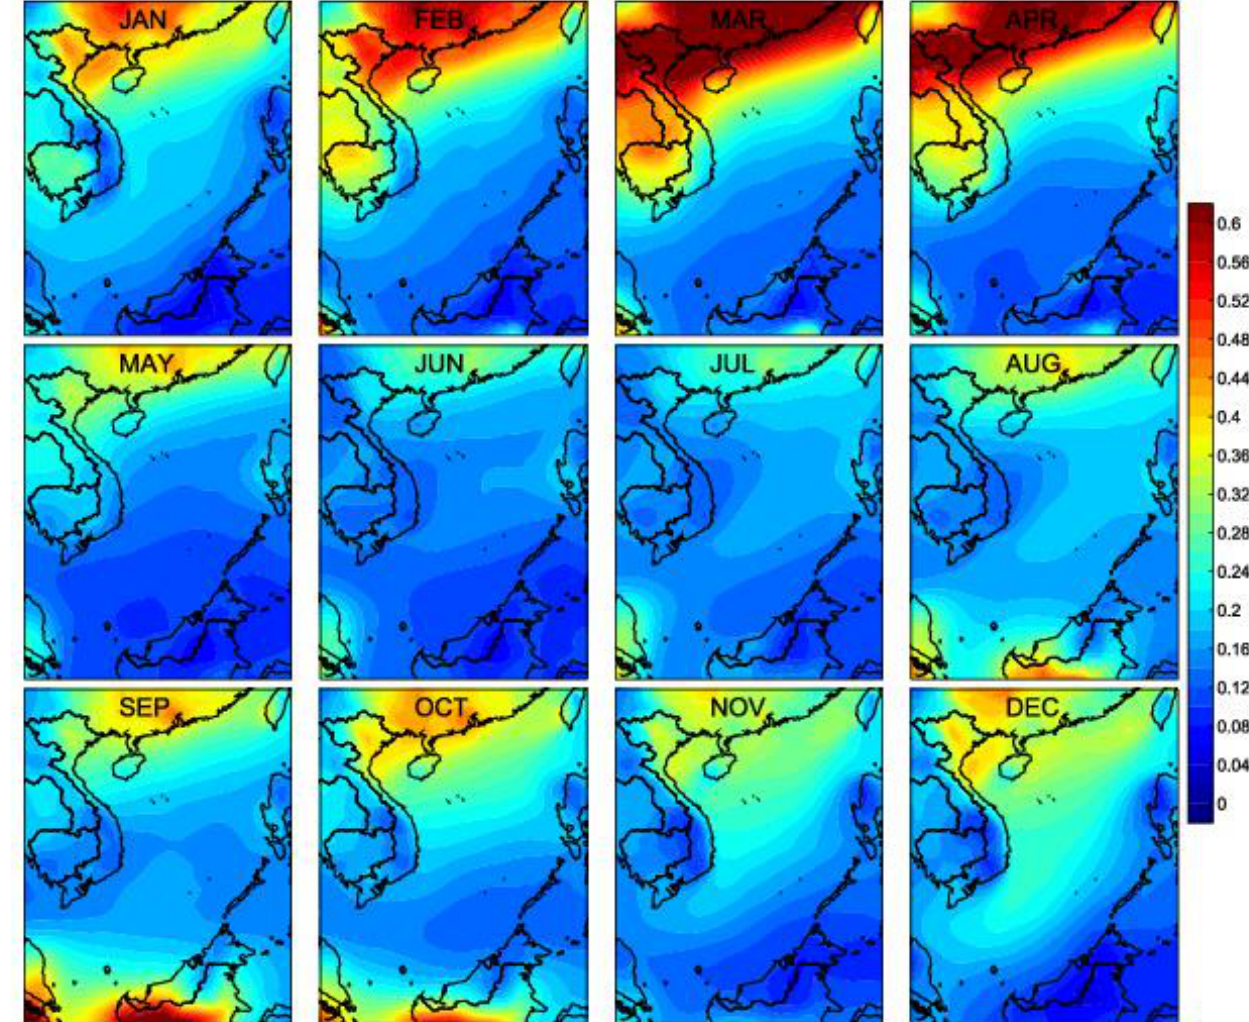
Figure 4. Spatial distribution of mean MERRA-2 AOD in each month in the period of 1980–2020. Scattering aerosol optical depth (SAOD) could be obtained by subtracting absorption aerosol optical depth (AAOD) from the total aerosol optical depth (TAOD) [50]. Mean values of MERRA-2 SAOD and AAOD between 1980 and 2020 over the SCS were shown